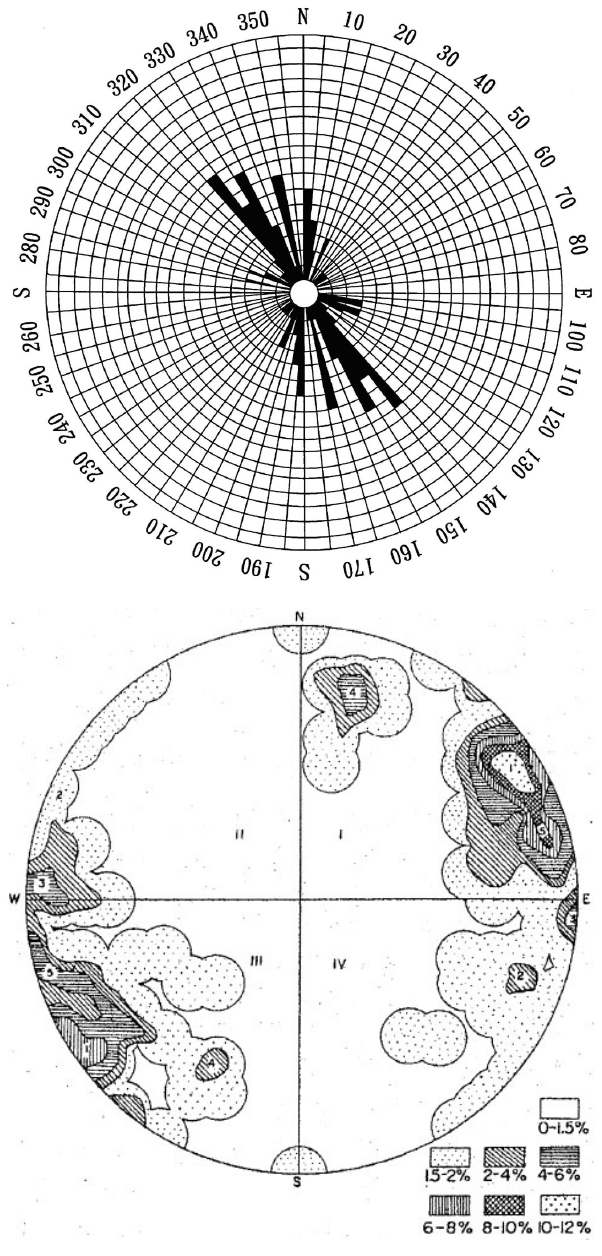
Fig. 4. (a) Rose diagram and (b) contour diagram of 67 joints of Jentse member in the Chingshui geothermal area (Tseng,